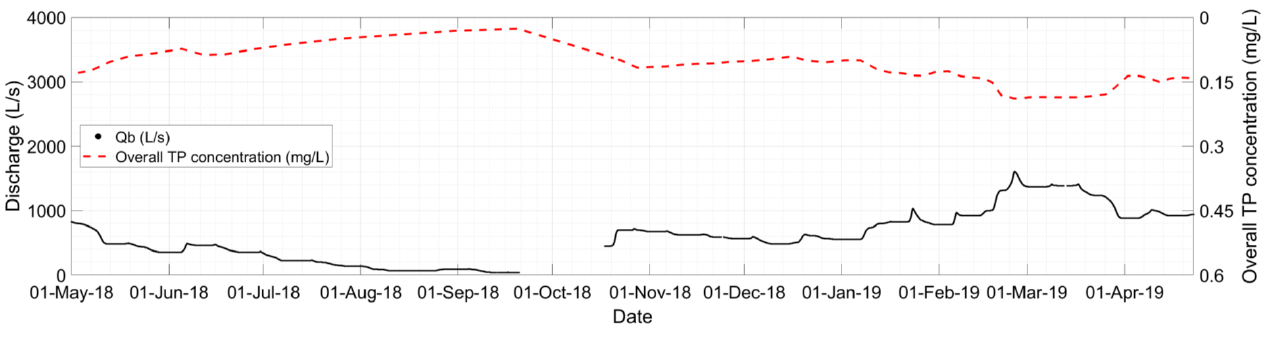
Figure 13. Comparison between mean baseflow and TP concentration. The figure shows that both curves follow a similar temporal pattern, indicating that the TP concentration and Qb have a direct connection.